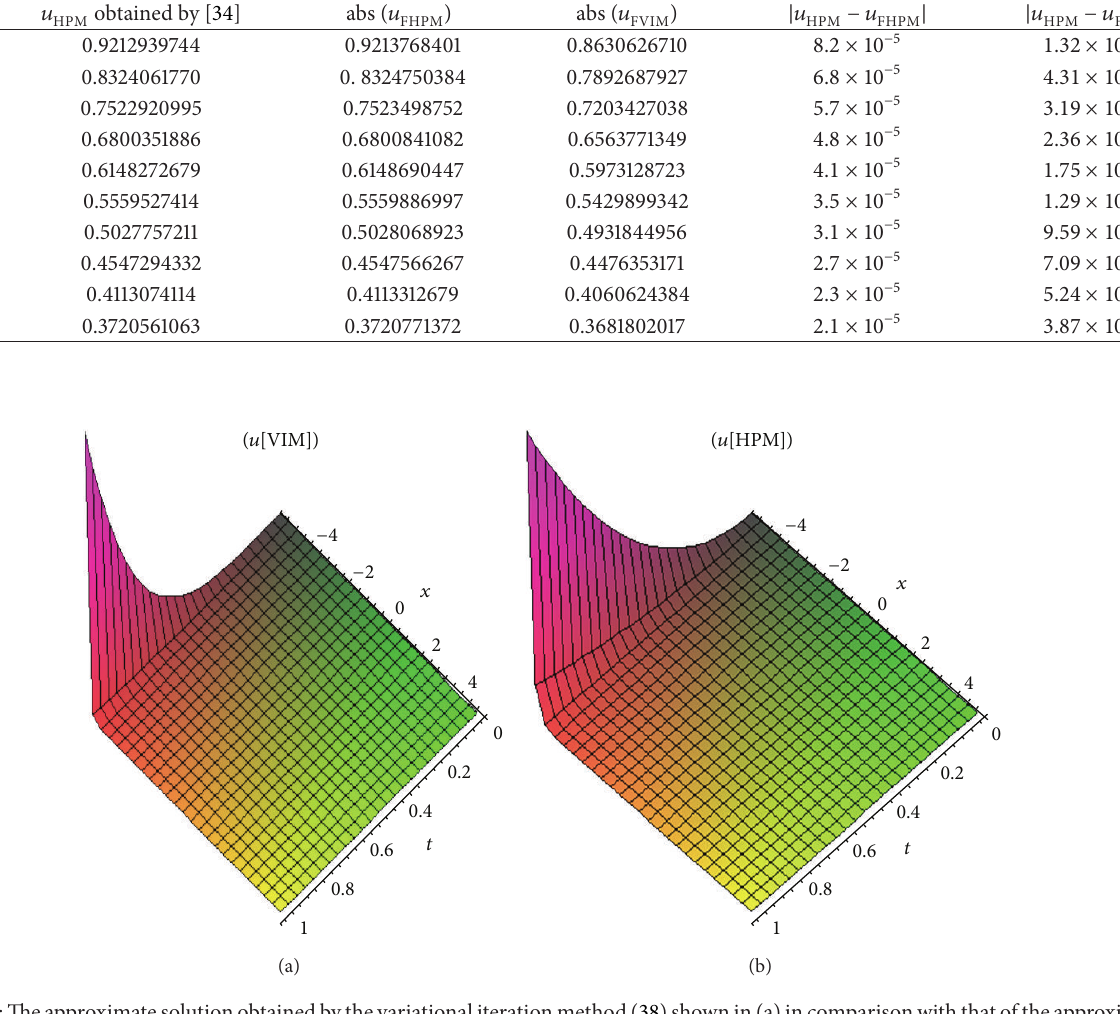
Figure 1: The approximate solution obtained by the variational iteration method (38) shown in (a) in comparison with that of the approximate solutions obtained by homotopy perturbation method (32) shown in (b) when 𝛼 = 1 , 𝛽 = 1 , −5 < 𝑥 < 5 , and 0 < 𝑡 < 1